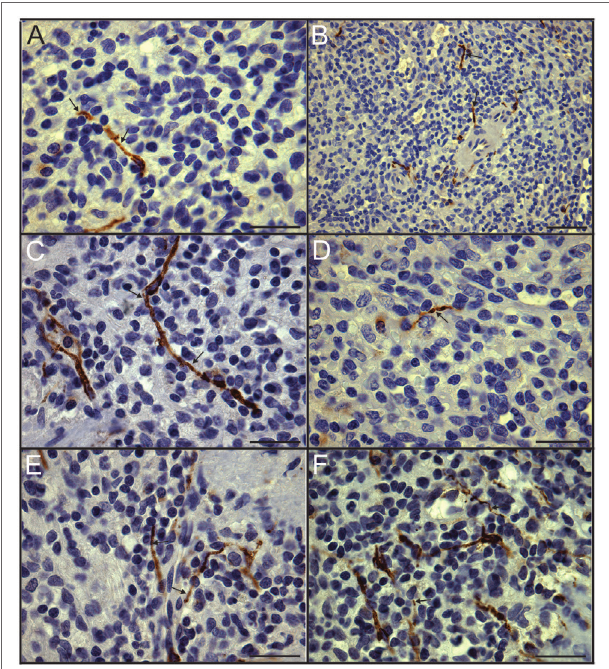
FigUre 3 | Close association of tyrosine hydroxylase (TH) + nerves and leukocytes demonstrated in dual stained sections. (a–F) High magnification images of control spleen sections with TH + nerves stained brown using DAB and nuclei stained blue with hematoxylin to enhance identification of leukocytes. Arrows indicate some TH + nerves in close apposition to leukocytes. Scale bars: 25 µm (a,c–F) ; 50 µm (b)